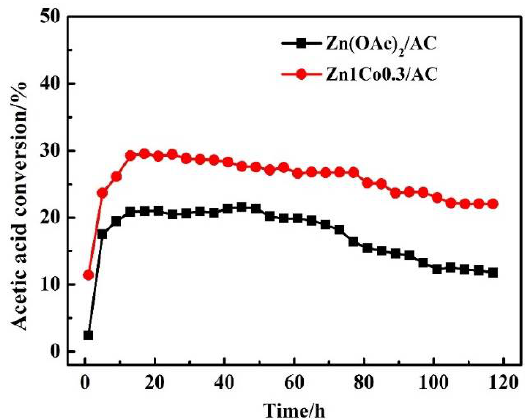
Figure 5. Stability evaluation of the Zn1Co0.3/AC and Zn(OAc) 2 /AC catalysts.